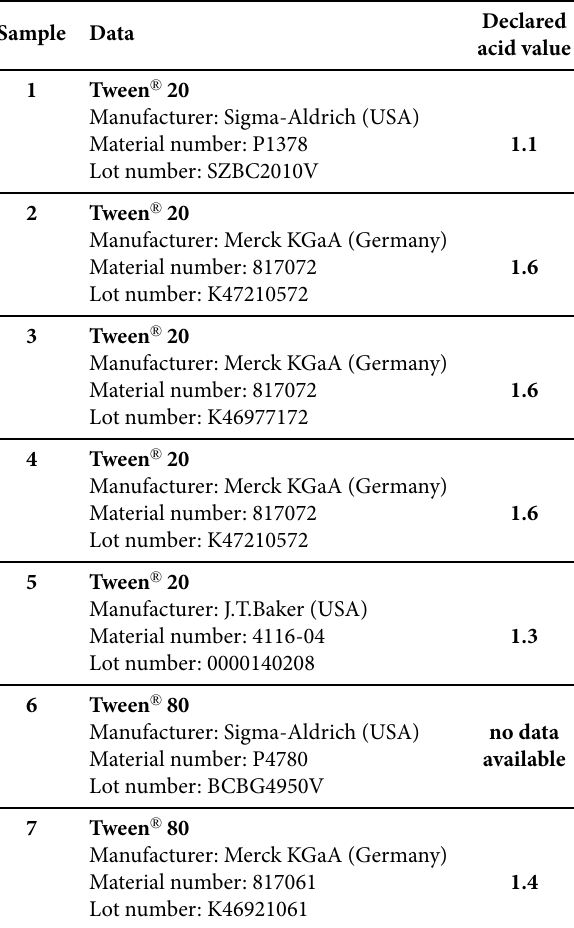
Table 2. Analysed PS samples with elapsed shelf life.